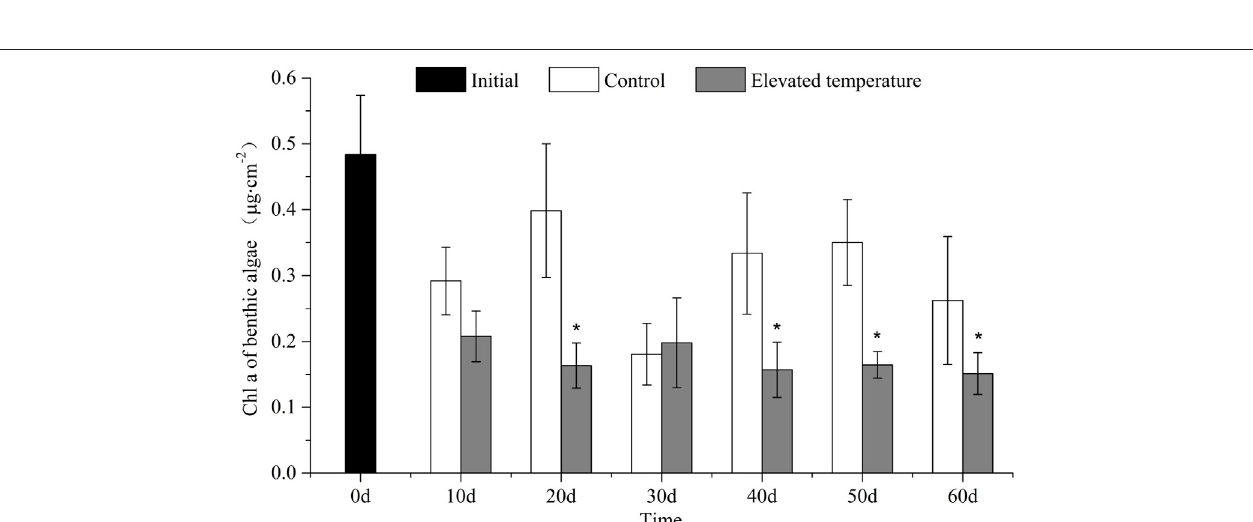
Frontiers in Environmental Science |